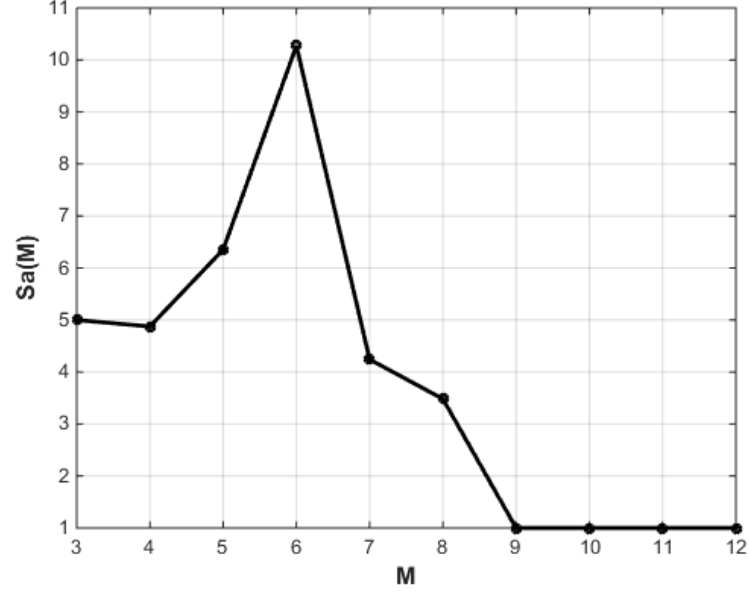
Figure 2. Relationship between the segmentation scale variable M and Sa(M) .